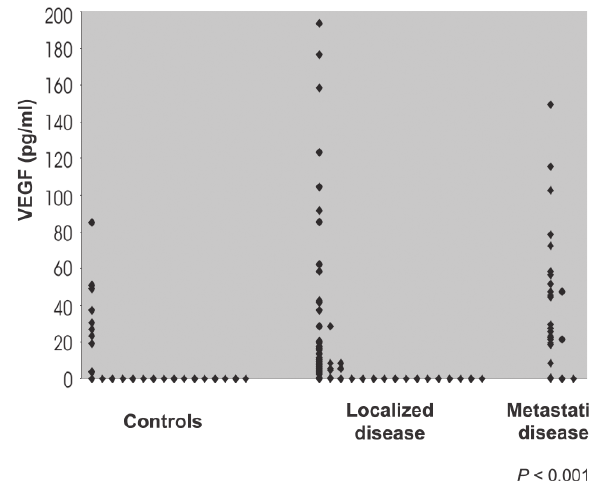
Figure 2 - Median plasma vascular endothelial growth factor (VEGF) concentrations in control, localized disease, and metastatic disease